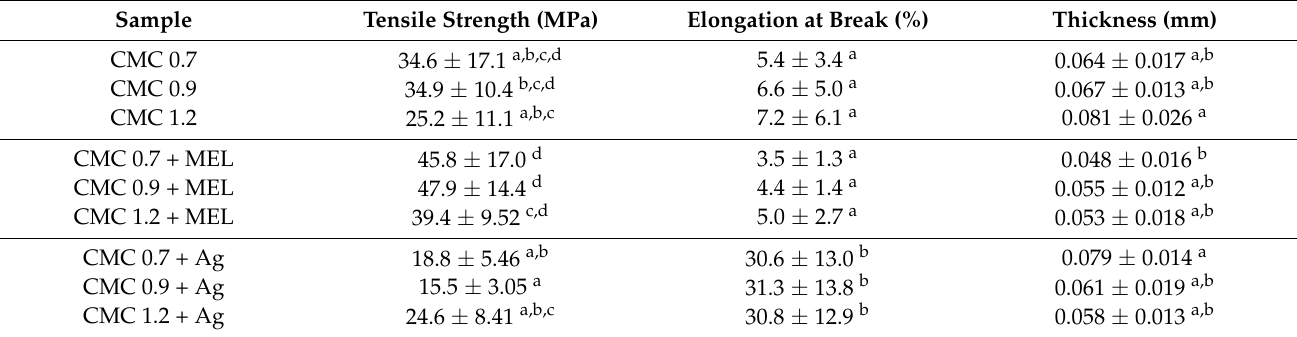
Table 1. Thickness and mechanical characteristics of unmodified and modified CMC